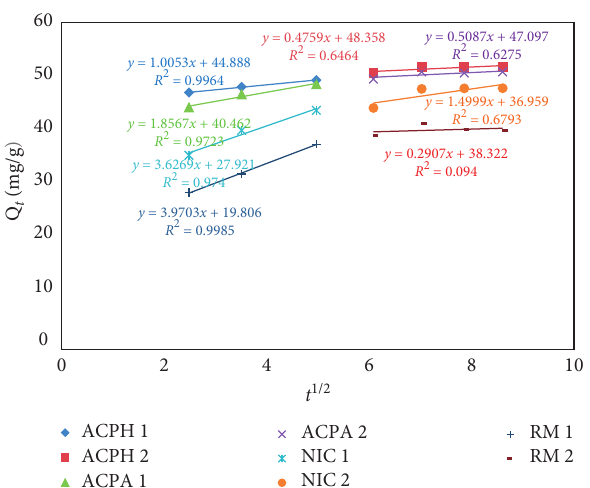
Figure 11: Intraparticle diffusion model for the adsorption of nickel(II) ions onto prepared activated carbon (ACPH, ACPA, and NIC) and raw material, RM. Table 7: Comparison of adsorption capacity (Ni 2+ ions) of activated carbons (adsorbents).